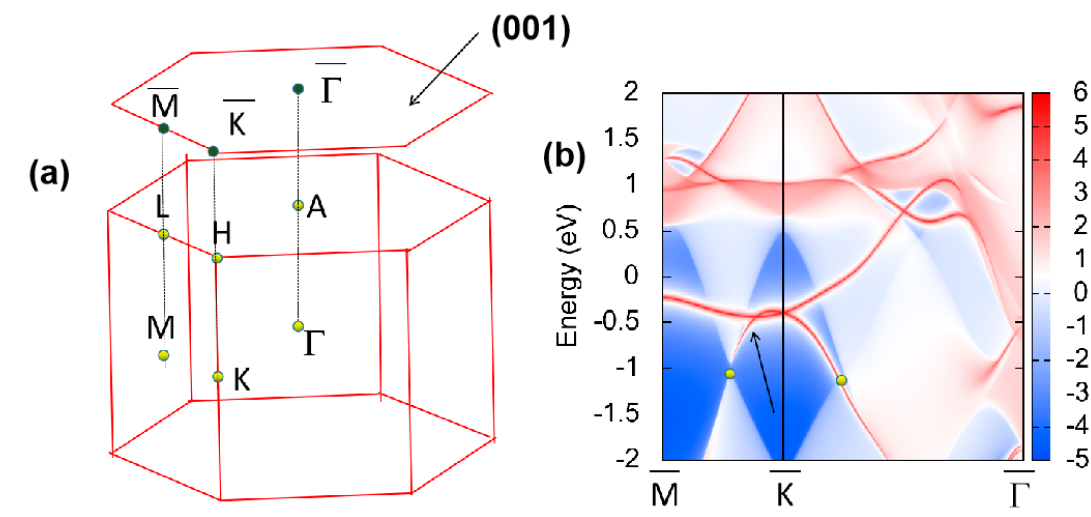
Figure 8. ( a ) 3D bulk BZ and 2D surface BZ and ( b ) projected spectrum on the (001) surface of CrB 2 . The band-crossing points and the nontrivial surface states are highlighted by the yellow balls and arrow, respectively.